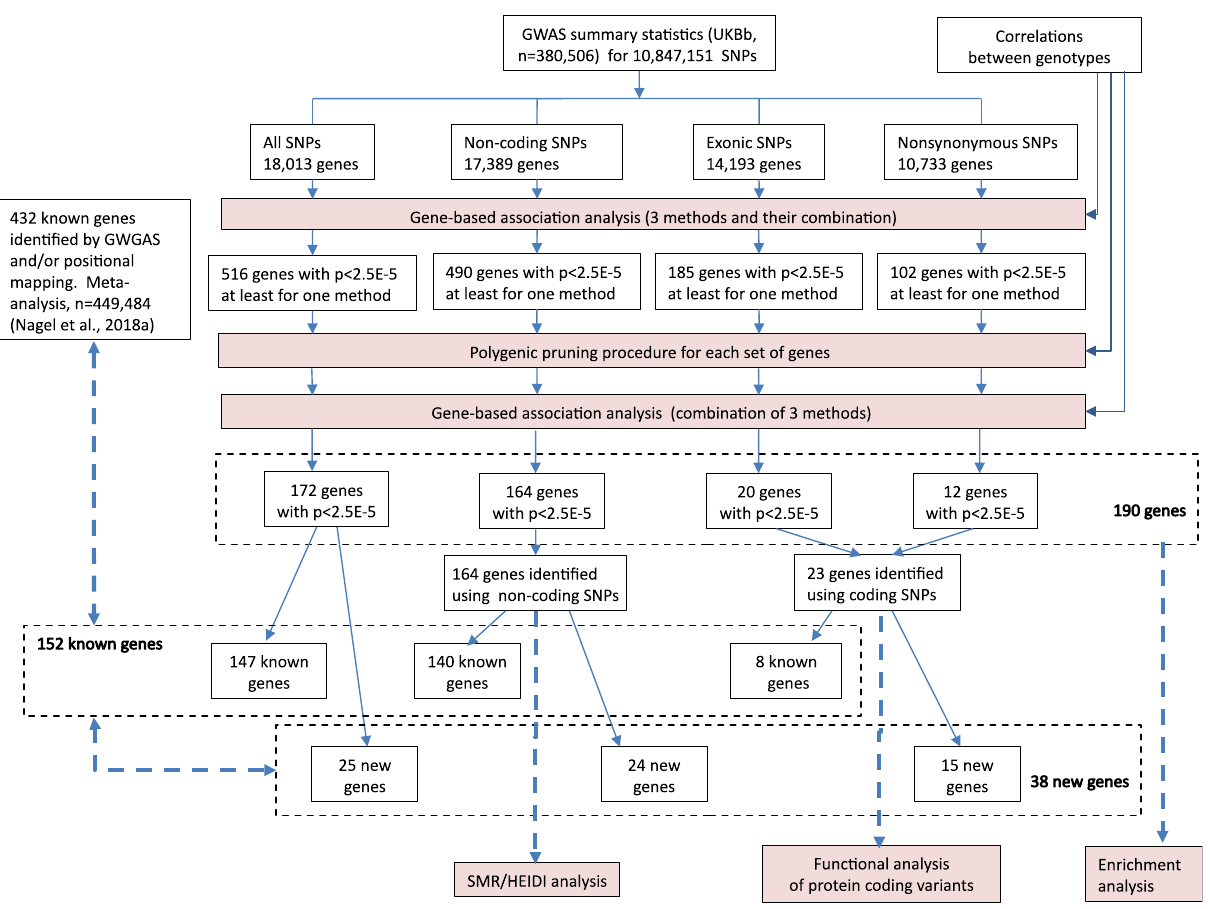
Figure 1. Workflow schematic. GWAS summary statistics and correlations between genotypes were used as input data. Each set of SNPs (all, non-coding, exonic and nonsynonymous) was analyzed separately. The